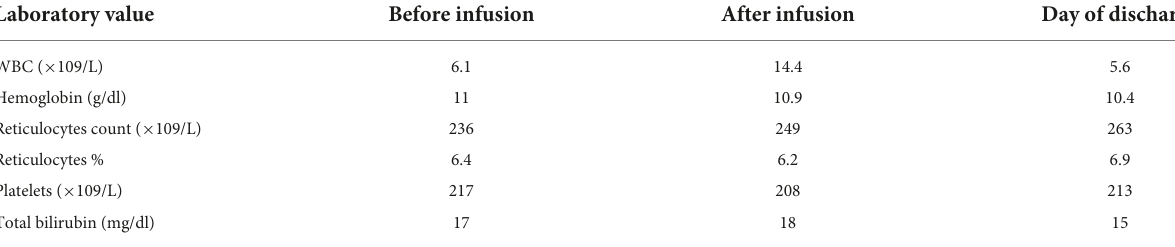
TABLE 1 Changes in laboratory results throughout admission.